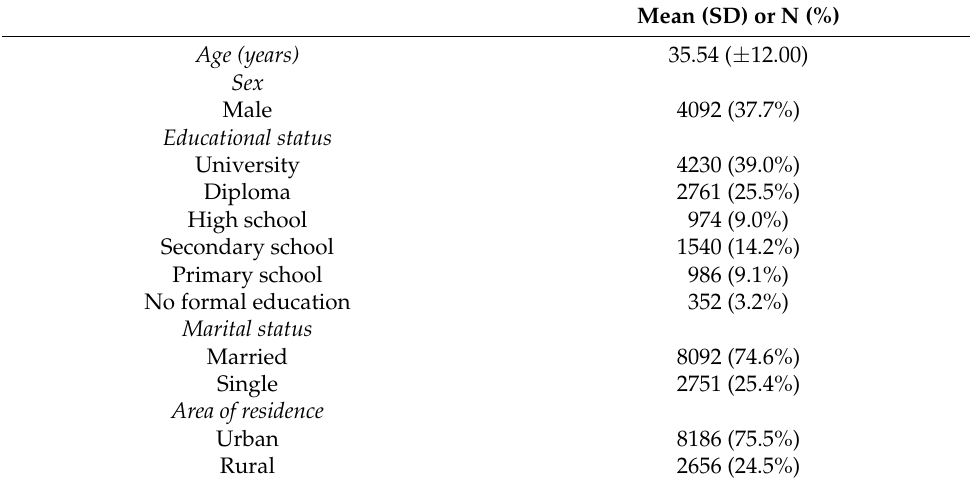
Table 1. The demographic characteristics of the participants ( N = 10,843).